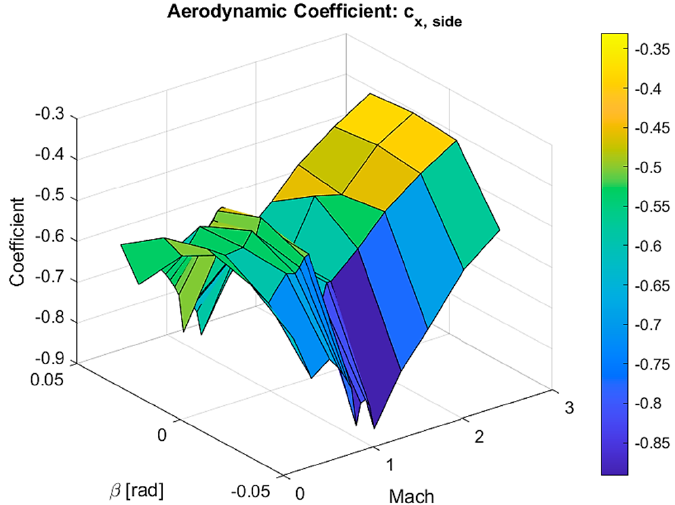
Figure 16. Axial drag coefficient as derived from the sideslip angle and Mach number.